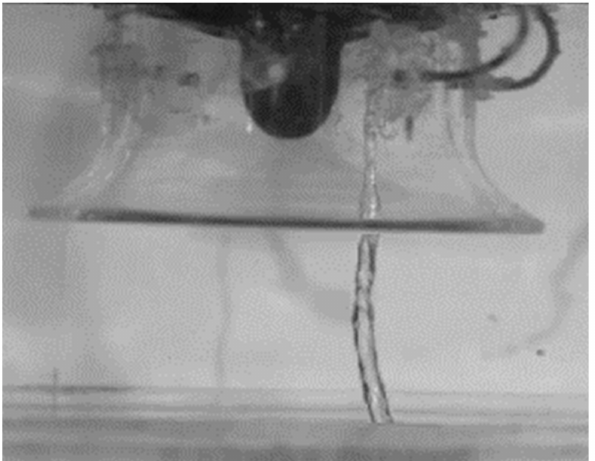
Figure 8. Physical vortex in the continuance